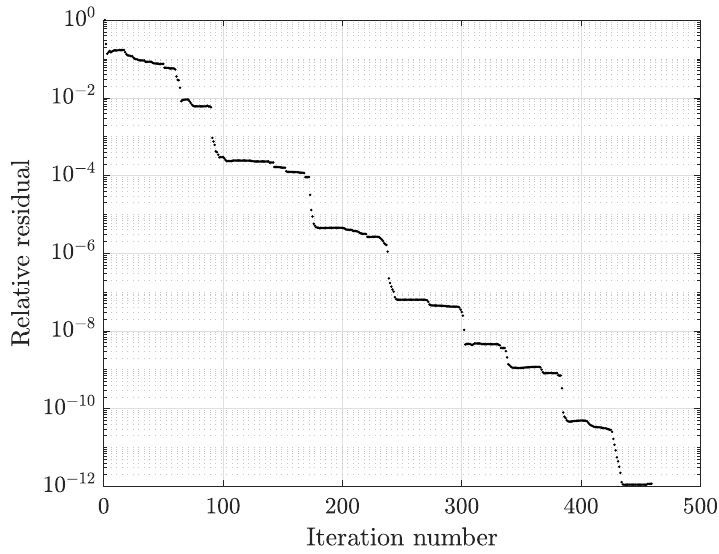
Figure 12. Convergence pattern of the TFQMR solver with SSOR preconditioning at 50 Hz. The y -axis and z -axis magnetic flux density components were evaluated along the horizontal line A-B of Figure 11 by both 3D CM–BEM and 3D FEM on 401 equally spaced points. Figures 13 and 14 show that field profiles at 50 Hz are in very good agreement. The maximum discrepancies from 3D FEM, for the real and imaginary parts of B y , are, respectively, 0.98% and 11.52%, whereas, for B z , they are 0.60% and 8.81%, respectively. Therefore, even by using a relatively coarse mesh refinement for CM–BEM, a good agree- ment with second-order FEM is obtained. Similar results were found at 200 Hz: 4.42% and 9.83%, respectively, for real and the imaginary part of B y (Figure 15), 3.72% and 9.36%, respectively, for the real and the imaginary part of B z (Figure 16).